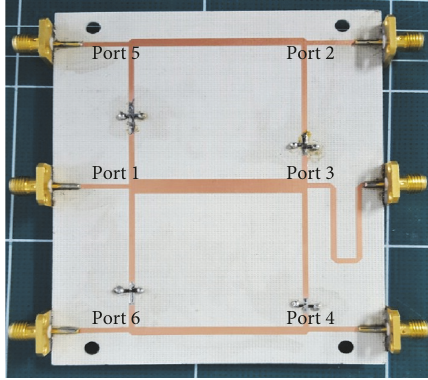
Figure 8: Prototypes of the coupler using PIN diode and bias-T.